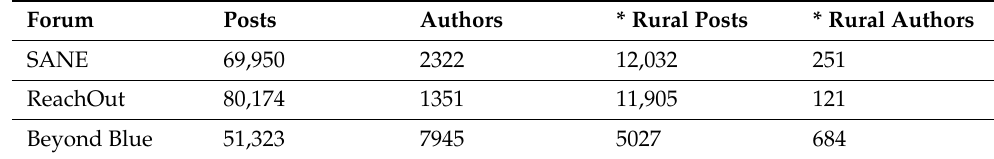
Table 1. Number of posts and individual authors by nonprofit organisation (August 2018–December